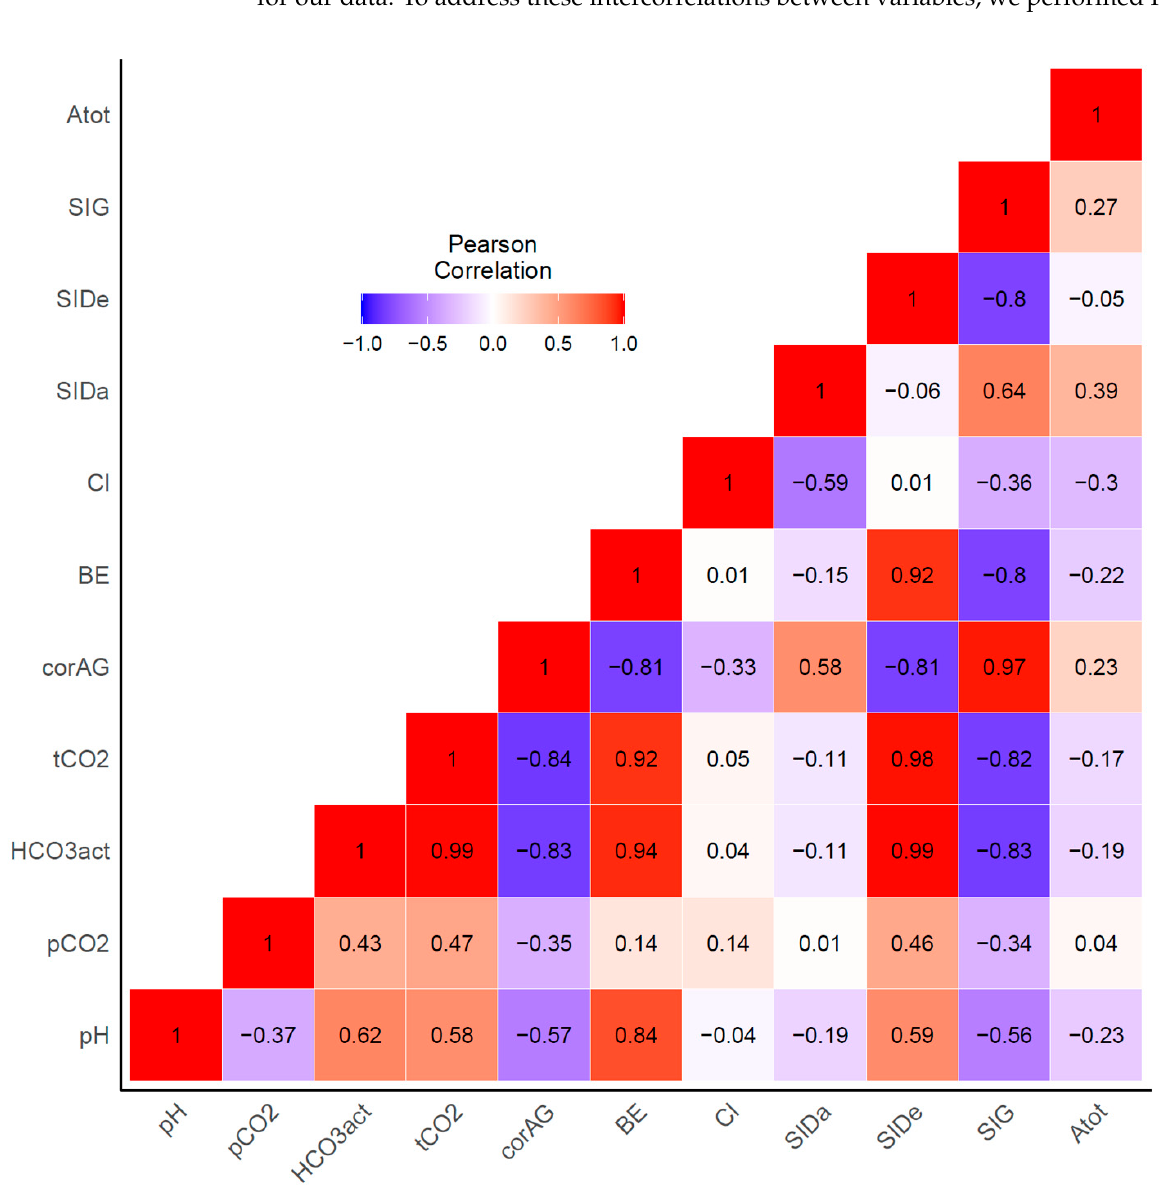
Figure 2. Pearson’s correlation between each parameter assessing acid-base status. A total of four PCs were selected based on eigenvalues of >1.0. Table 4 shows the eigenvalue of the PCA. Overall, 95% of the total variance could be explained by 4 PCs. Based on the PCA, we interrogated the hidden axes explaining acid-base status (Figure 3). SIDe, HCO 3 − , tCO 2 , BE, corAG, and pH were loaded to PC1, the first principal component. PC1 accounted for 52.0% of the total variance. Given the results, we referred to PC1 as the total buffer base. PC2 was associated with SIDa and chloride. PC3 was correlated with pCO 2 , suggesting a respiratory component of the acid-base balance. PC4 was associated with A Tot , implying the weak acid’s role in the pathogenesis of acid-base disturbances in patients with pesticide poisoning.